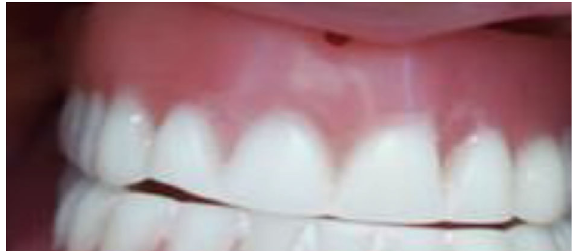
Figure 2: Prosthesis